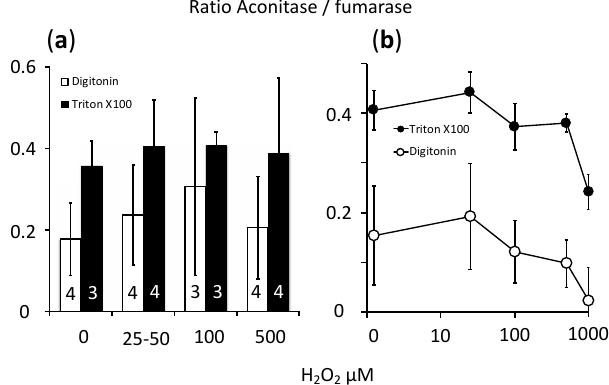
Figure 6. Evaluation of cellular oxidative stress using the aconitase to fumarase ratio in CHO cells exposed to H 2 O 2 . Y axis = aconitase to fumarase ratio; X axis = H 2 O 2 concentration. ( a ) Empty bars = values observed in cells treated with digitonin (cytosolic activities); filled bars = values observed in cells treated with Triton X100 (both cytosolic and mitochondrial activities); values expressed as mean ± SD; the number of independent experiments is indicated at the bottom of the histogram bars. ( b ) Single experiment with the concentration of H 2 O 2 raised to 1 mM; values expressed as mean and SD of the wells observed in that